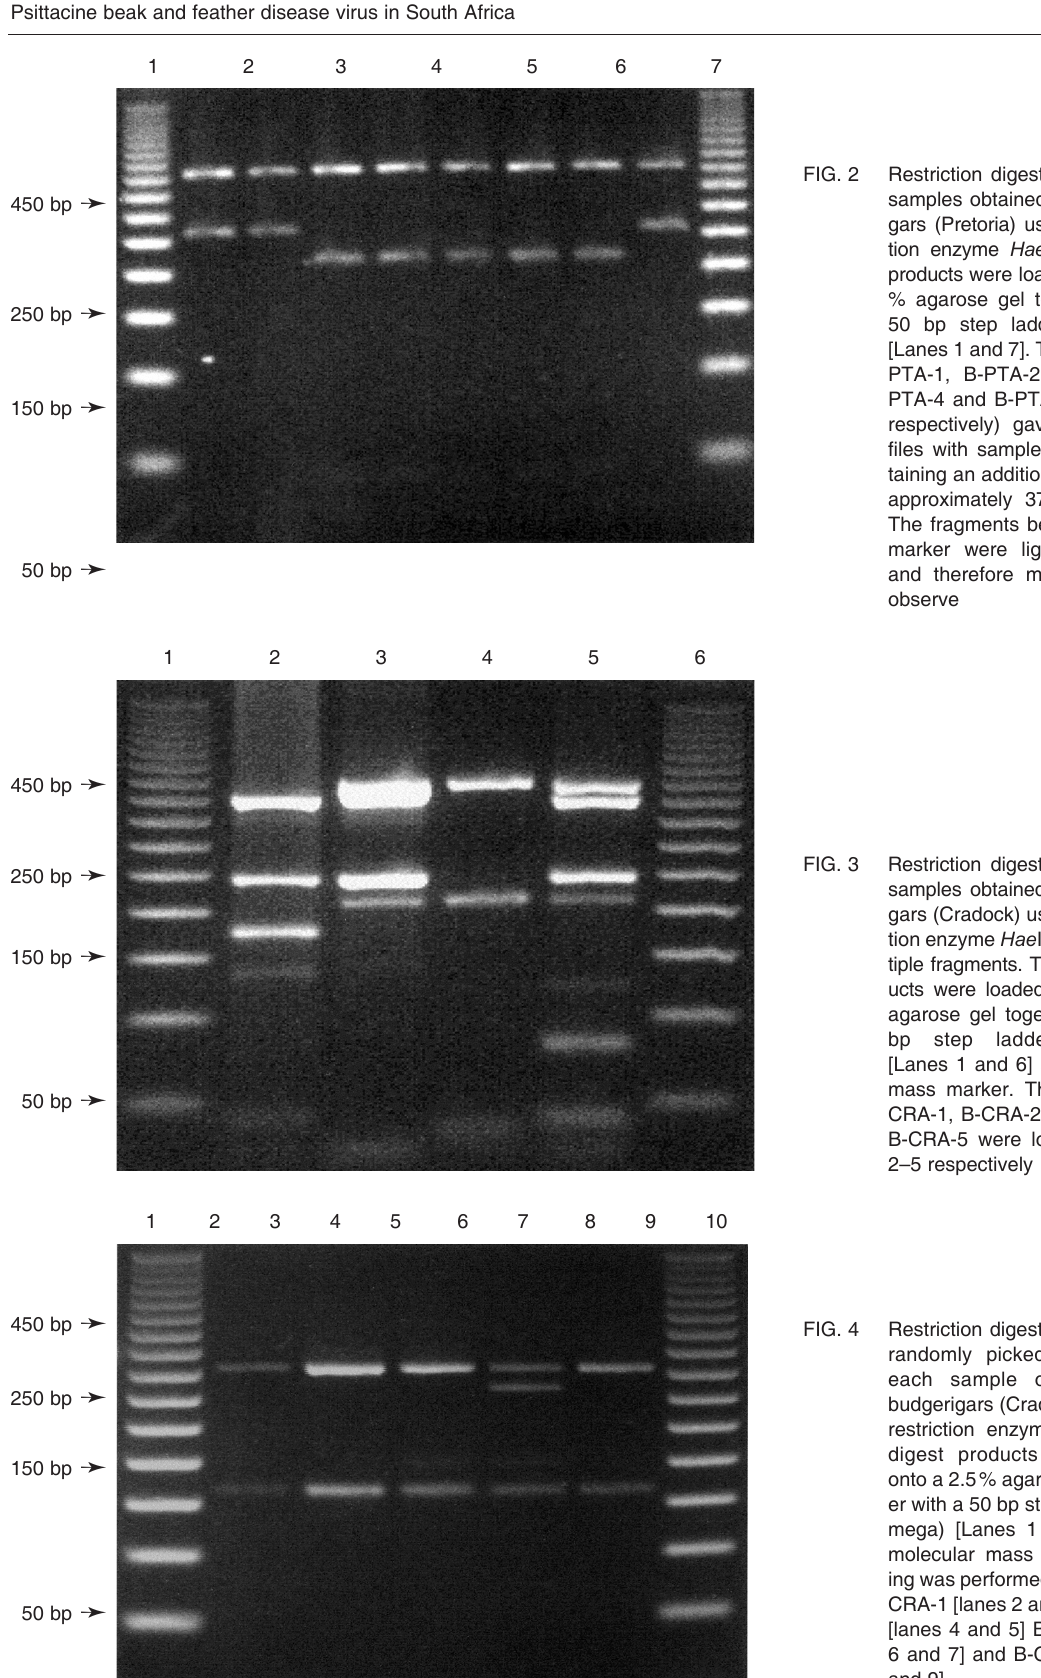
FIG. 4 Restriction digest profile for two randomly picked clones from each sample obtained from budgerigars (Cradock) using the restriction enzyme Hae III. The digest products were loaded onto a 2.5% agarose gel togeth- er with a 50 bp step ladder (Pro- mega) [Lanes 1 and 10] as a molecular mass marker. Load- ing was performed as follows, B- CRA-1 [lanes 2 and 3], B-CRA-2 [lanes 4 and 5] B-CRA-4 [lanes 6 and 7] and B-CRA-5 [lanes 8 and